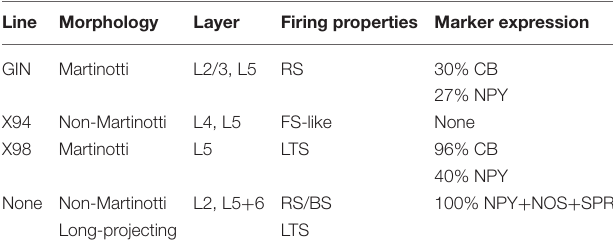
TABLE 1 | Four main subtypes of SOM cells (including 3 labeled by specific transgenic lines) with a minimal degree of overlap. Line